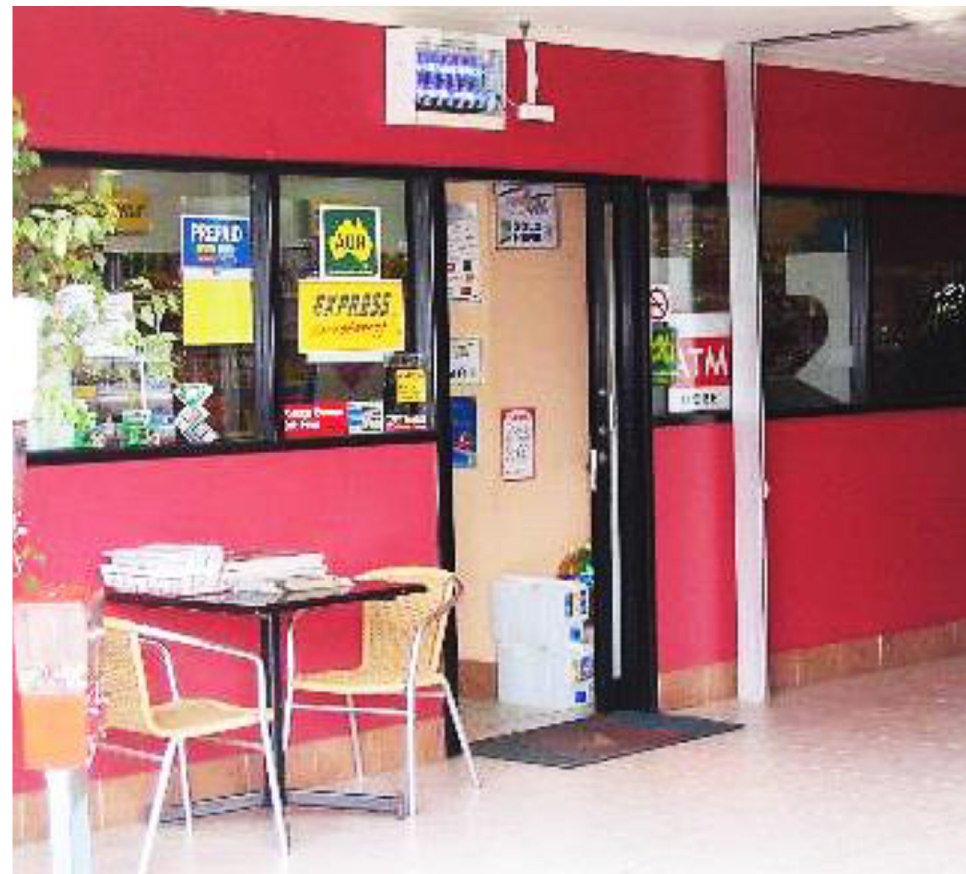
Figure 4. Zapper trap over a dining table. Restaurant door propped open.